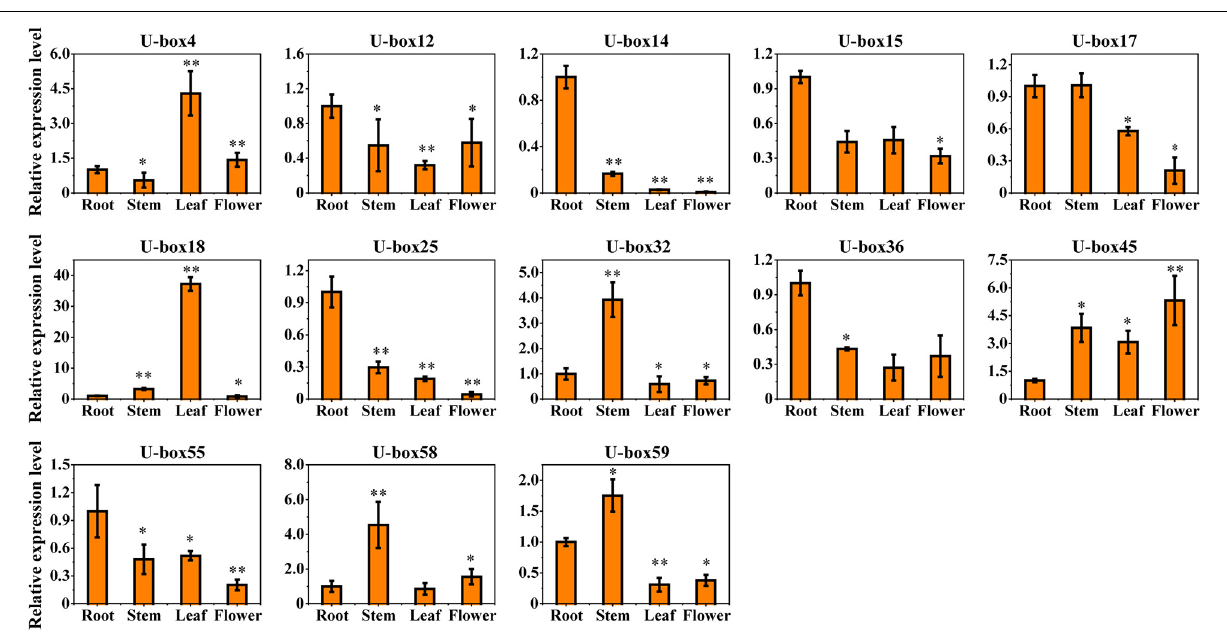
Frontiers in Plant Science |